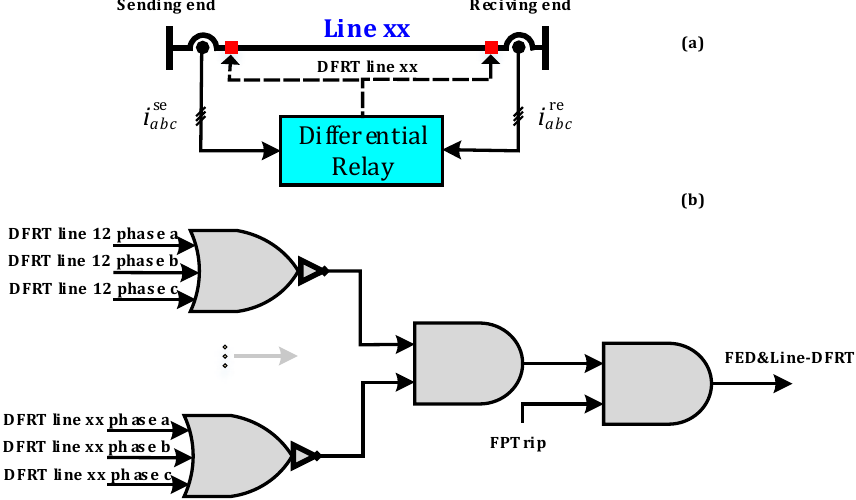
Figure 3. The proposed protection scheme for lines. ( a ) DFR protection scheme for line protection as main protection, and ( b ) FED&Line-DFRT signal command creating for DGU’s back up